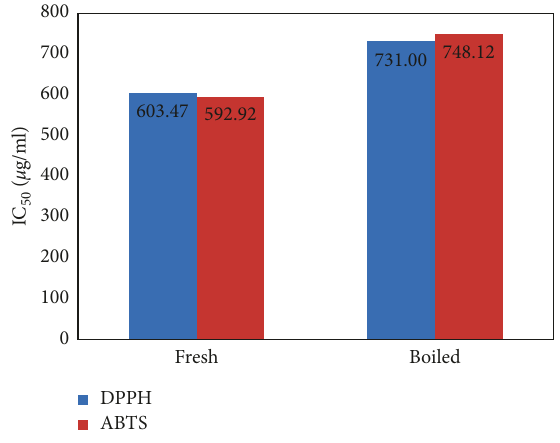
Figure 4: IC 50 of the free-radical scavenging assay of extracts from fresh and boiled W. globosa .